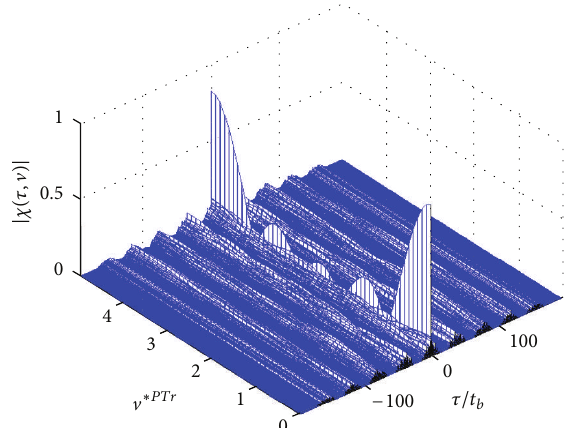
Figure 6: Ambiguity function of Chaos NNS MCPC I.